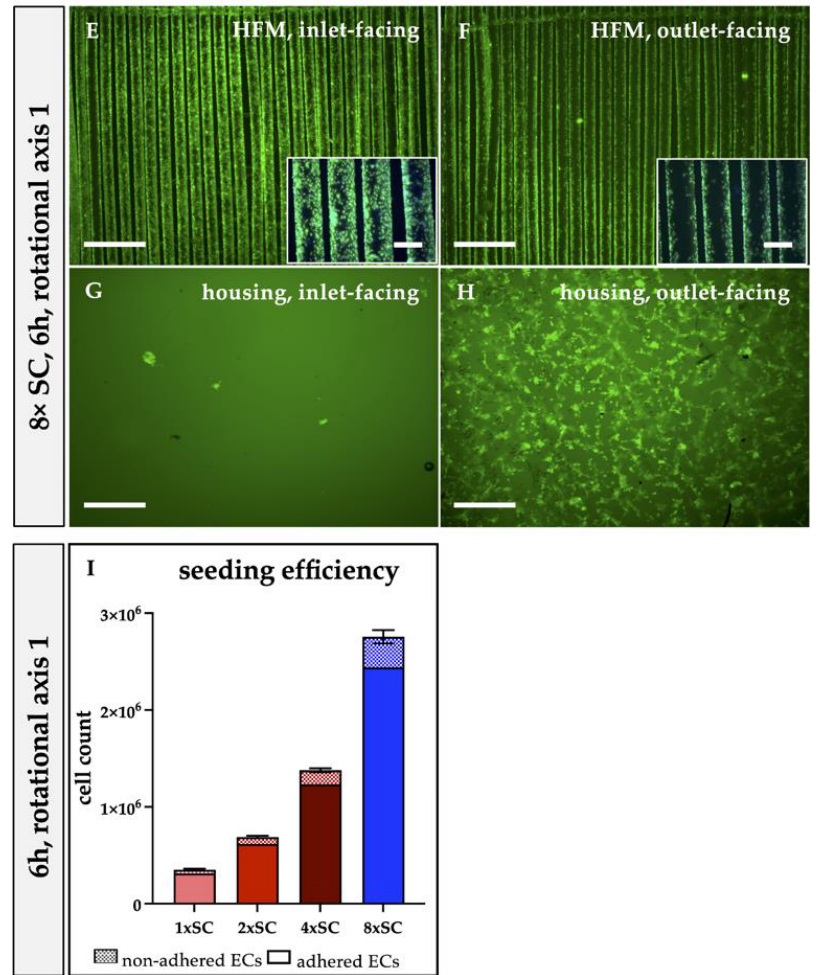
Figure 2. Improved seeding efficiency depended on applied EC concentration. Fluorescence microscopy was performed on HFMs ( A , B , E , F ) and the housing ( C , D , G , H ), facing the inlet ( A , C , E , G ) and the outlet ( B , D , F , H ), after seeding with 1 × SC ( A – D ) or 8 × SC ( E – H ) and using calcein (green)/Hoechst 33342 (blue) staining. Scale: 2 mm; insert boxes in A, B, E, F, scale: 400 µm. ( I ) Quantification of percent adherent ECs after incubation with different seeding concentrations. SC: seeding concentration.